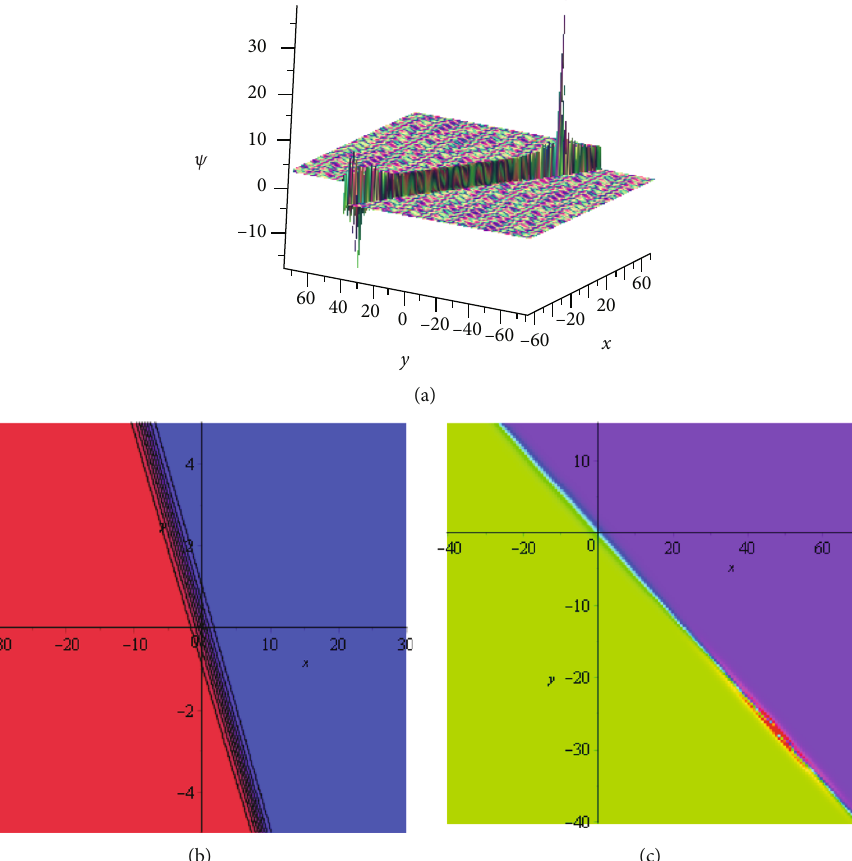
= : 5, a = 1 : 5, a = 2, a = 1, Ω = 1 : 9, Ω = : 2, Ω = 2, δ = 1, δ = 1 : 3 1 2 3 4 4 5 7 1 2